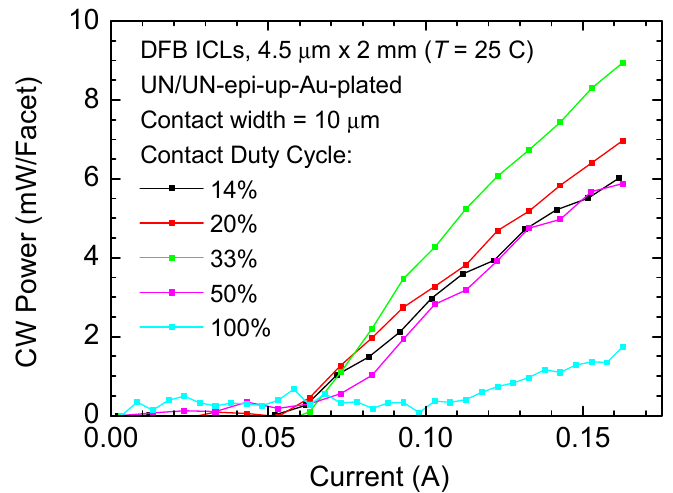
Figure 15. Light-current characteristics in cw mode at room temperature for DFB ICL ridges (4.5- μ m-wide, 2-mm-long) with fill factors of 14, 20, 33, 50, and 100%. The performance of all of these devices was degraded by higher-than-normal sidewall leakage.